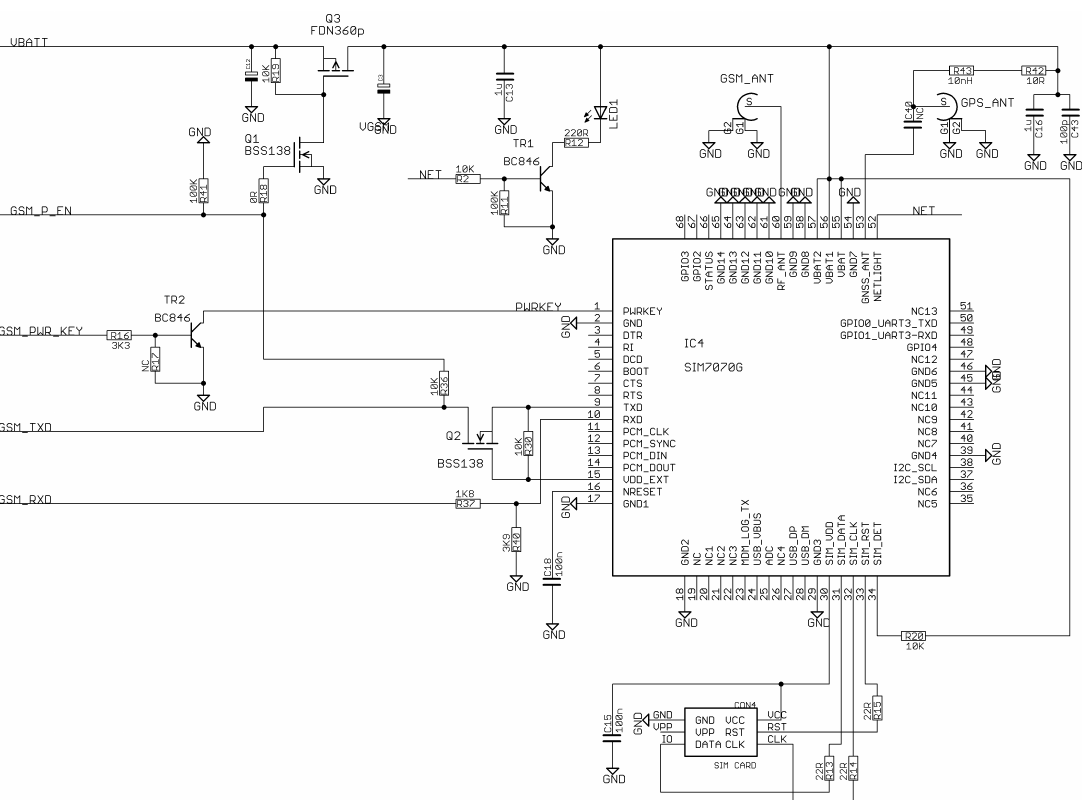
Figure A6. Electronic amplifier circuit of the weight sensor. It accepts input from the weight sensor and gives a voltage that is proportional to the weight. Voltage to weight conversion is performed on the system processor.